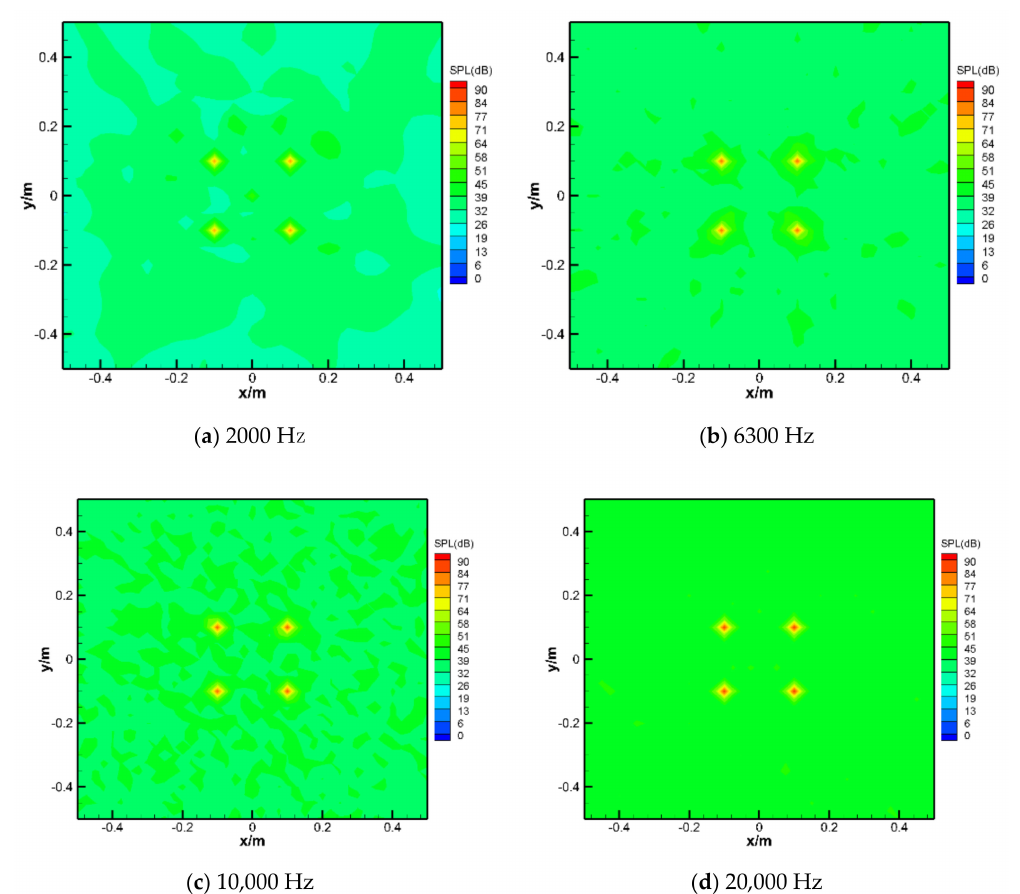
Figure 2. Sound source distribution for subcase A at different frequencies.